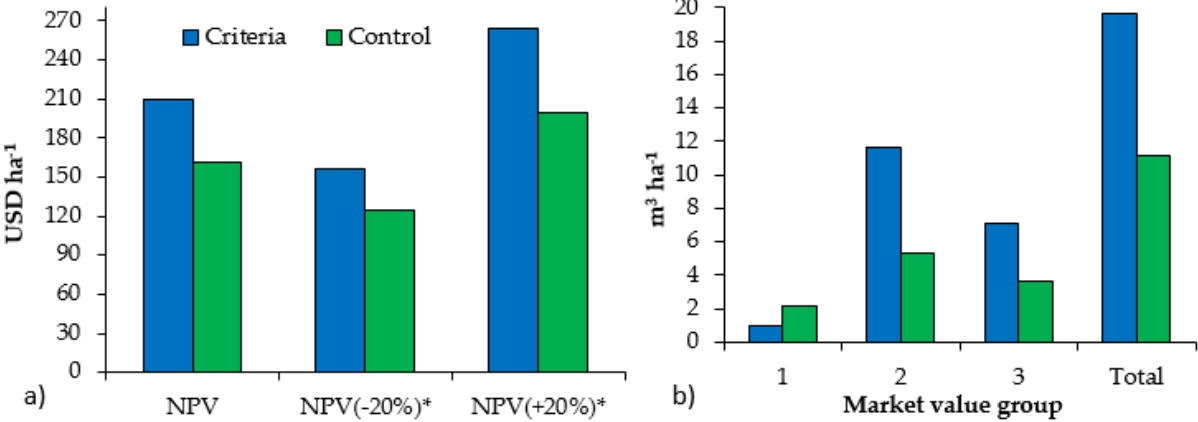
Figure 4. Financial indicators (NPV ha −1 ) ( a ) and production (m 3 ha −1 ) by the market value group of species destined for the commercialization of standing wood ( b ) for the criteria and control treatments, forest management area of Fazenda Shet, Dom Eliseu, State of Pará, Brazil. * NPV result of the projection of ±20% in the commercialization price of standing wood.